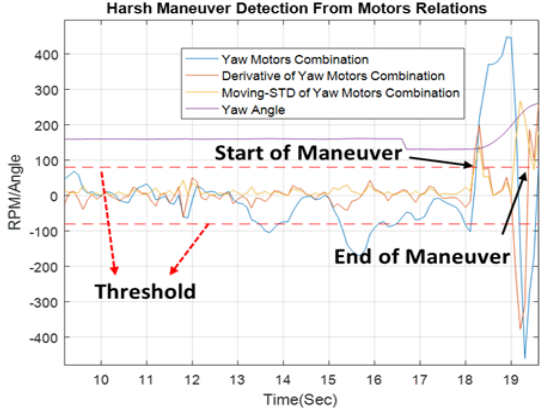
Figure 9. Harsh maneuver detection according to VM motors relations.